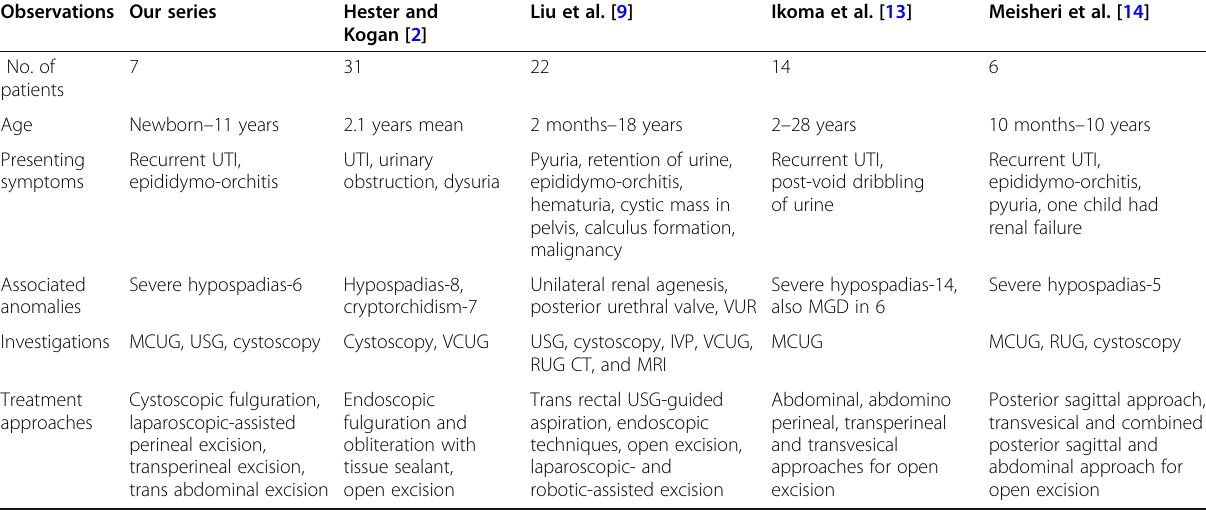
Table 2 Various studies reporting clinical presentations and treatment approaches for treatment of prostatic utricle Observations Our series